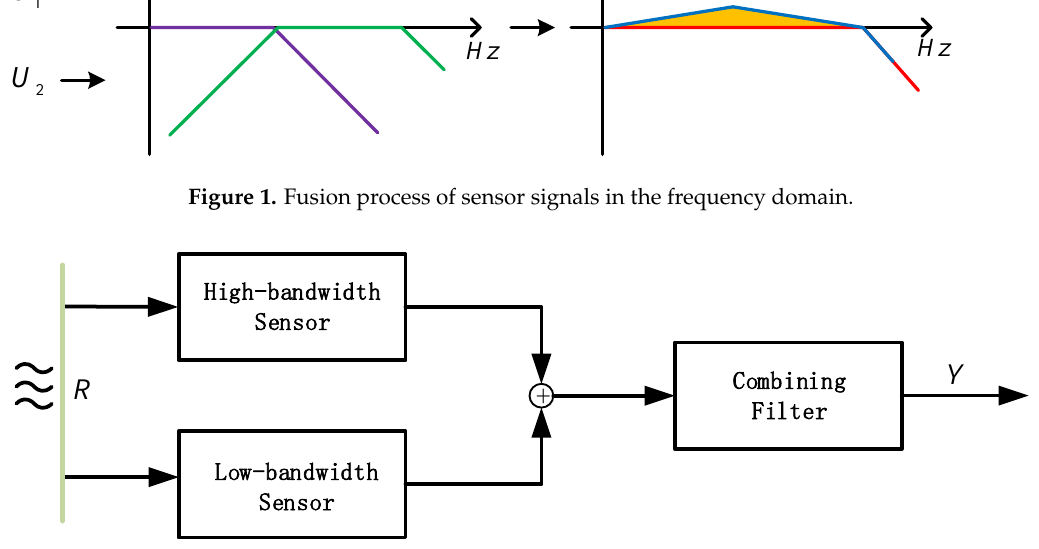
Figure 2. Fusion process of combining filter method.